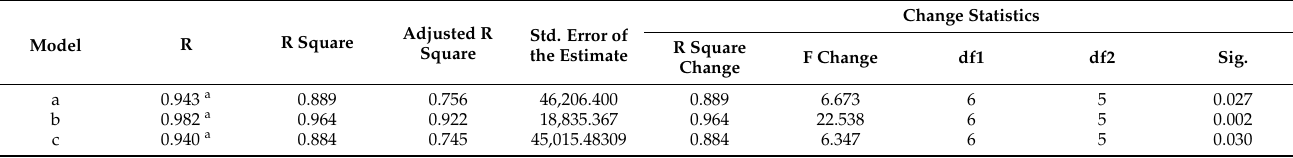
Table 6. SLR: Model Summary.